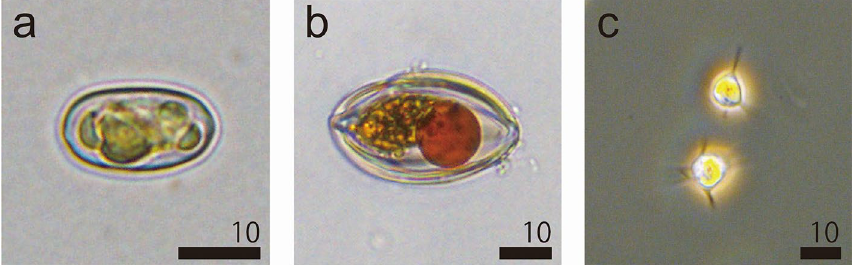
Figure 6. Most abundant snow algae collected in May, 2018. ( a ) Green snow cells (LM: Chloromonas sp.), ( b ) orange snow cells (LM: dormant state of Chloromonas sp.). ( c ) golden-brown snow cells (PCM: Ochromonas sp.). All scale bars in micrometers.